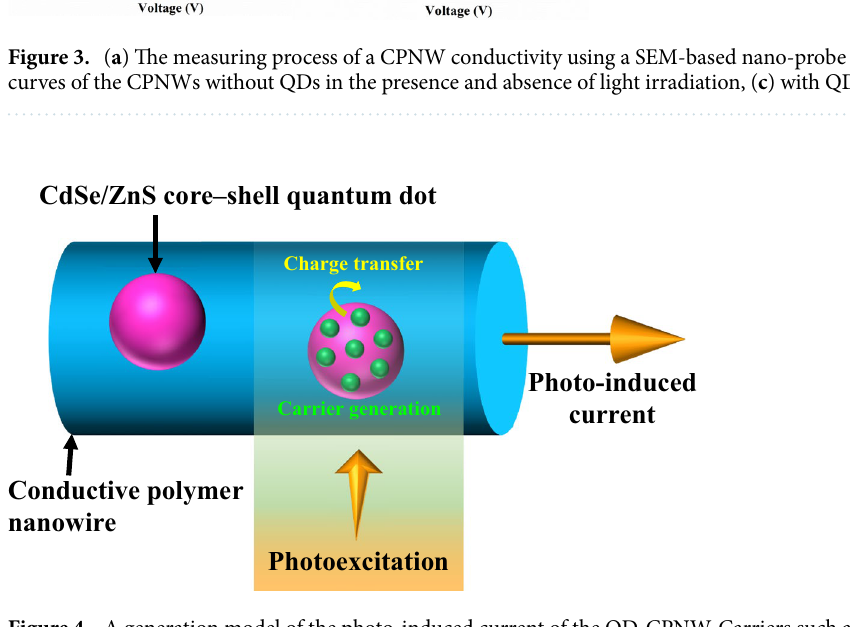
Figure 4. A generation model of the photo-induced current of the QD-CPNW. Carriers such as electrons and holes are generated efficiently in the QDs under weak light irradiation, and charge transfer from the QDs to CPNW occurs, which is observed as the photo-induced